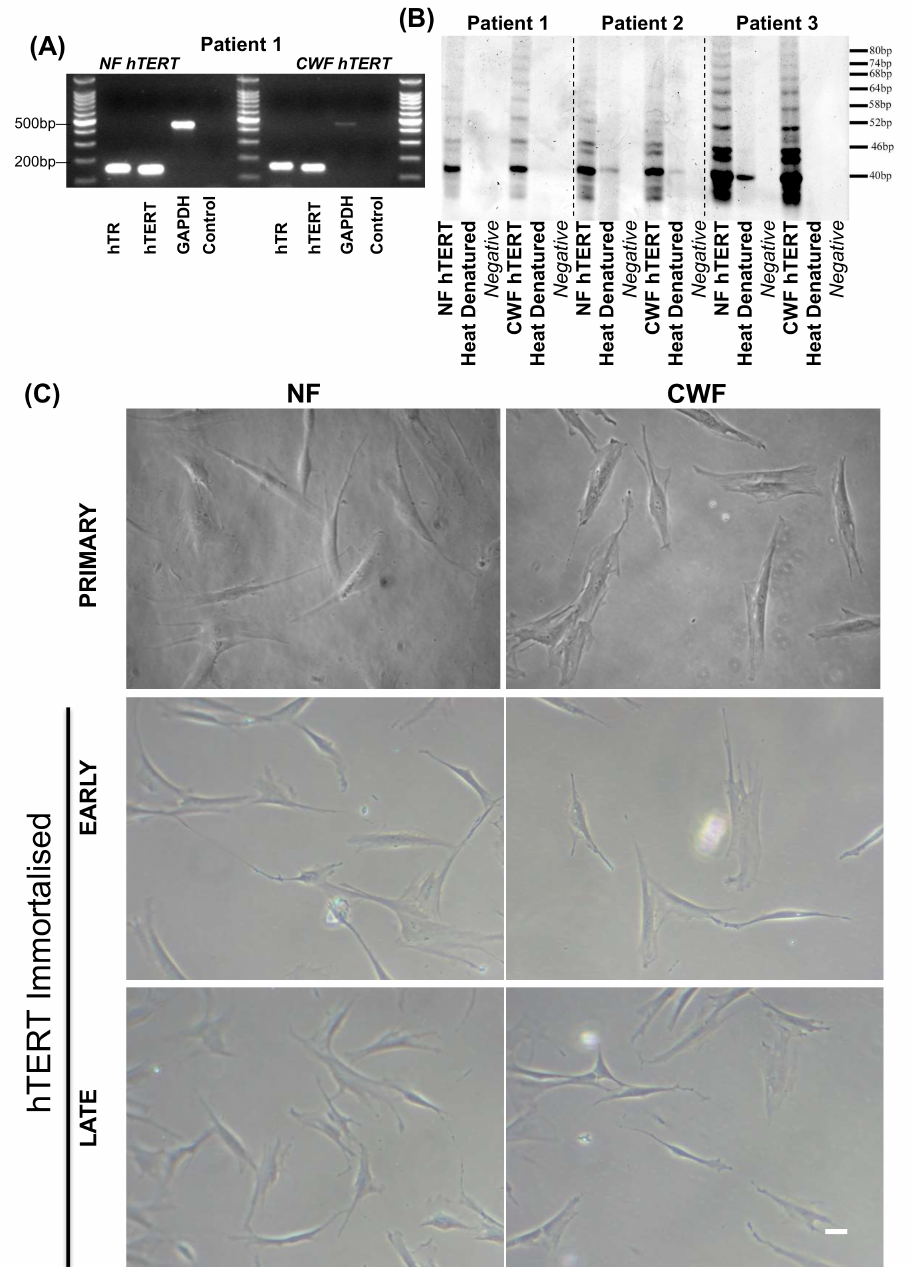
Figure 2. Immortalised NF and CWF cell lines express hTERT and template component (hTR) as demonstrated by RT-PCR ( A ) and have active telomerase as demonstrated by the appearance of a 6 bp ladder ( B ). CWF immortalisation and maintenance in culture ( C ) changes the appearance of the chronic cells from flattened and spread out to more bi-polar (and thereby more like the appearance of the NF cells). Scale bar = 20 µ